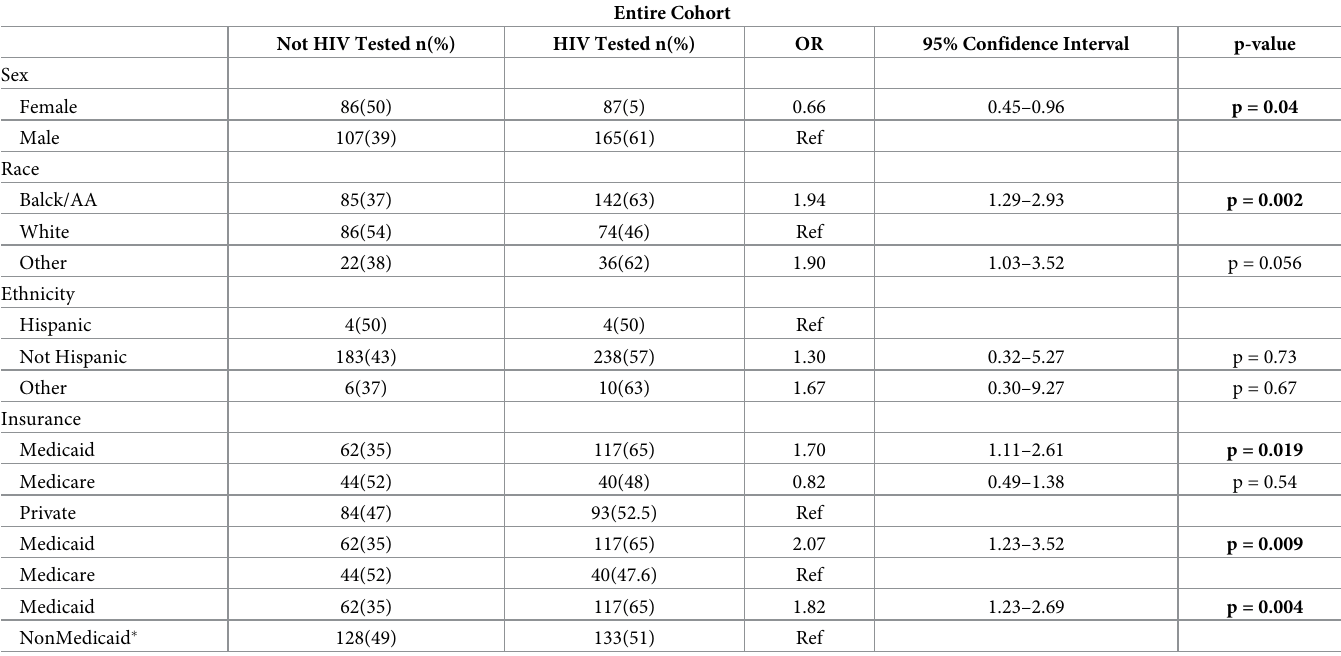
Table 2. Univariable analysis of HIV testing rates in the entire